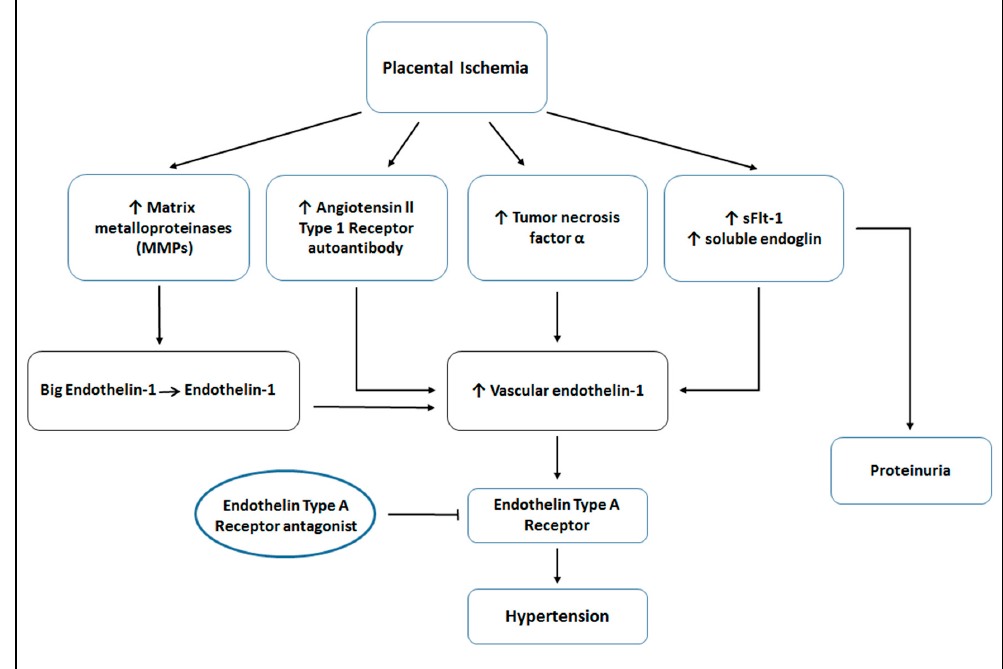
Figure 1. Factors leading to hypertension in response to placental ischemia. Placental ischemia is associated with increases in several factors, such as matrix metalloproteinases (MMPs), angiotensin II type 1 receptor autoantibody (AT1-AA), tumor necrosis factor- α (TNF- α ), soluble endoglin, and soluble fms-like tyrosine kinase-1 (sFlt-1). MMPs cleave big endothelin to active endothelin. These circulating factors lead to increased levels of vascular endothelin-1 (ET-1) expression and subsequent ET A activation, resulting in hypertension. ET antagonists may reduce hypertension, therefore improving maternal and fetal outcomes.